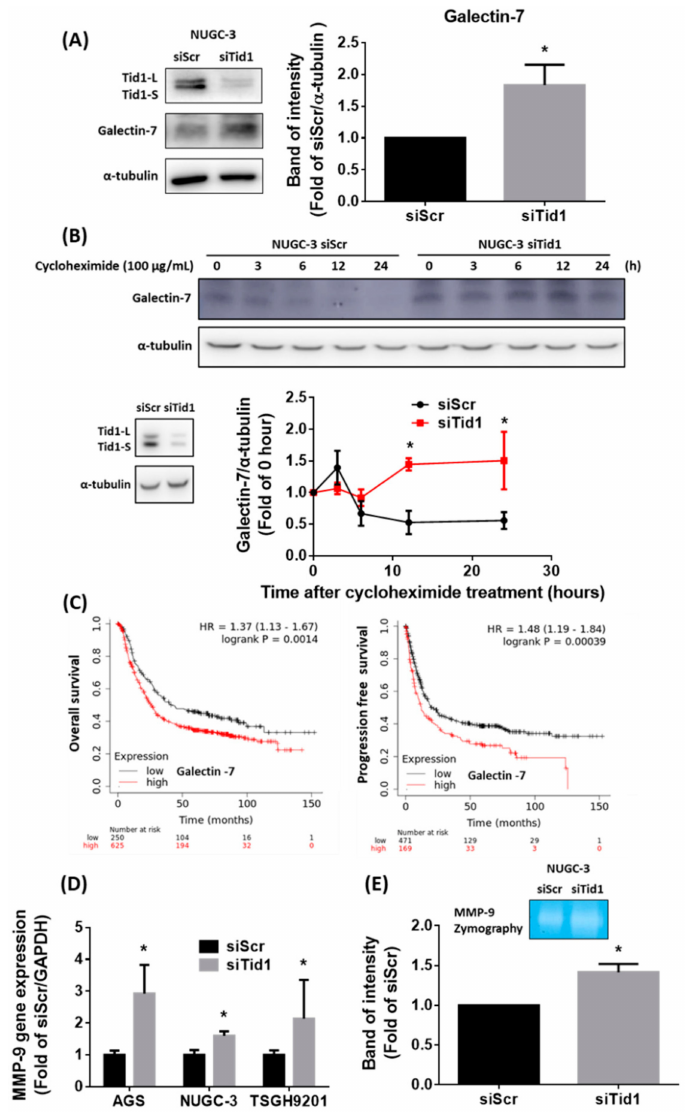
Figure 7. The Tid1-galectin-7-MMP-9 pathway might contribute to cell migration and invasion in NUGC-3 gastric cancer cells. ( A ) The effect of Tid1 knockdown on galectin-7 expression was determined by Western blot. ( B ) The effect of Tid1 knockdown on galectin-7 protein stability was determined by cycloheximide chase analysis. After knockdown of Tid1 by siRNA, the gastric cancer cells were reseeded and treated with cycloheximide for the indicated time periods. ( C ) Kaplan–Meier survival analyses were performed using the Kaplan–Meier plotter online database (http: // kmplot.com / analysis / ) [47]. The results showed the effect of galectin-7 gene expression on overall survival (OS, left) and progression-free survival (PFS, right) in gastric cancer patients. ( D , E ) The effects of Tid1 knockdown on gene expression and activity of MMP-9 were determined by ( D ) RT-real-time PCR and ( E ) gelatin zymography analysis. The efficiency of Tid1 knockdown was confirmed by Western blot and RT-real-time PCR. Data are shown as the mean ± SD of at least three independent experiments. *, p < 0.05, compared with the siRNA for scramble (siScr) control